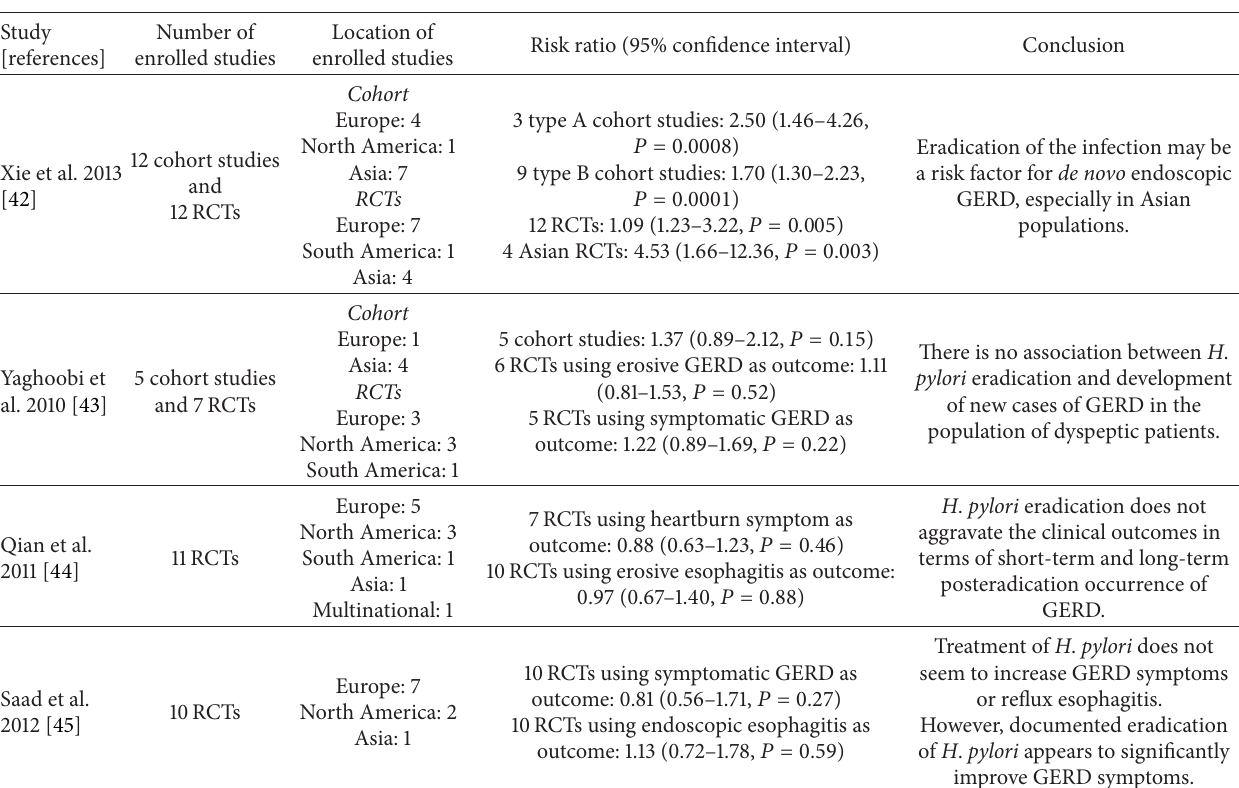
Table 2: Results of meta-analyses for Helicobacter pylori eradication on